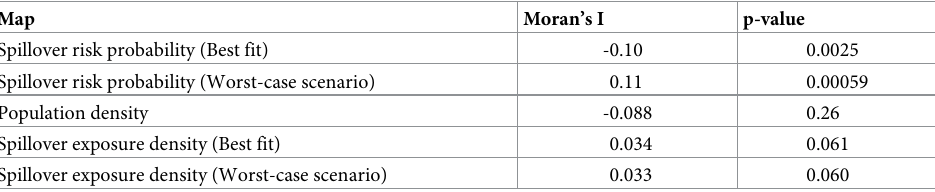
Table 8. Results of Moran’s test.